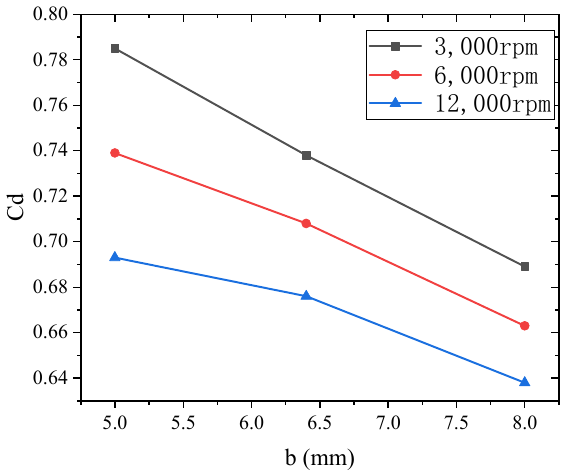
Figure 10. Tooth pitch–leakage characteristic curve at different rotating speeds.